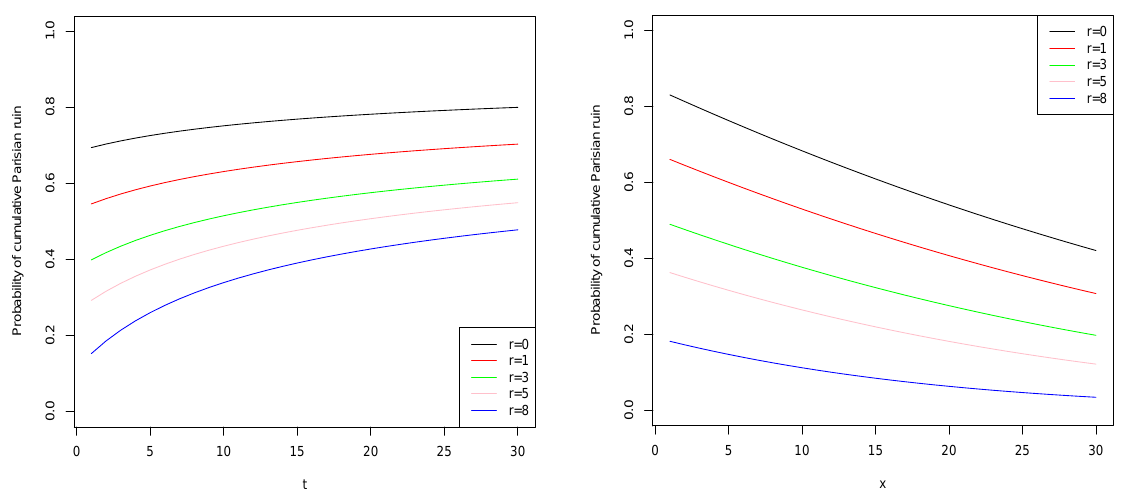
Figure 2. The probability of cumulative Parisian ruin for the Cramér–Lundberg process with α = 1/8, λ = 2, c = 17, r = 1, x = 10 and t = 10.